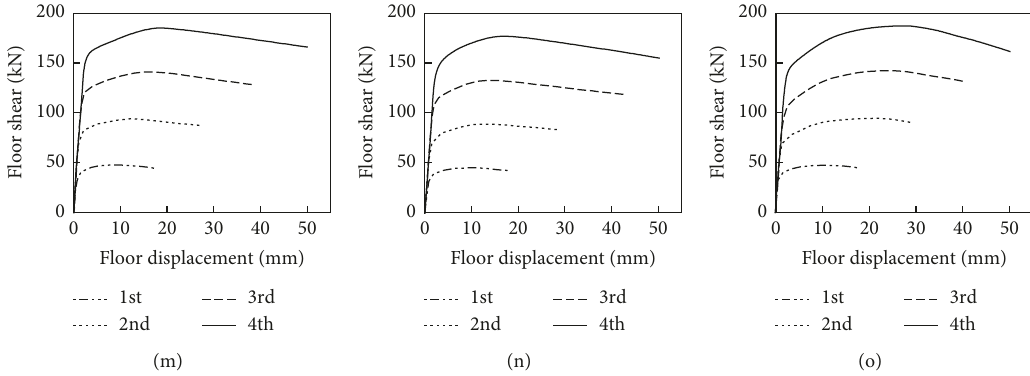
Figure 6: Horizontal floor force-lateral displacement curve